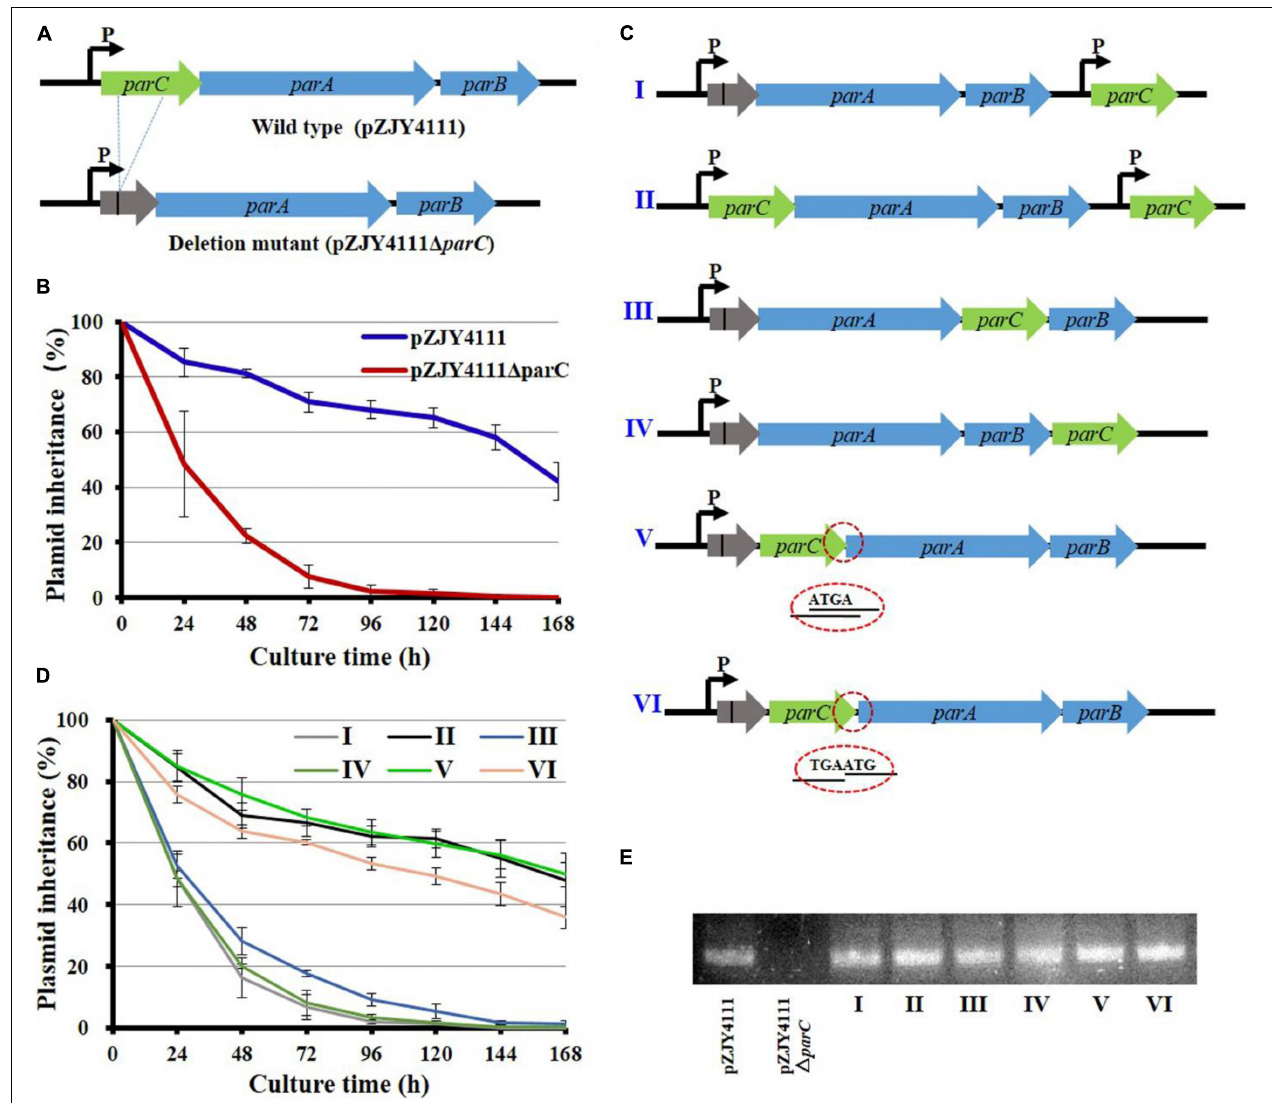
FIGURE 1 | Mutation and organization of the parC gene in the shuttle plasmid pZJY4111 and its effects on the inheritance stability of plasmid. (A) In-frame deletion of parC of the parCAB operon in pZJY4111. The deletion removed 228 bases and retained 11 N-terminal bases and 25 C-terminal bases of parC (referred to Supplementary Figure 3 ), producing plasmid pZJY4111 (cid:49) parC , which was further electro-transformed into M. xanthus DZ1 to assay the plasmid retention ability. Arrows indicate the direction of transcription. (B) Inheritance stability of pZJY4111 and pZJY4111 (cid:49) parC in M. xanthus DZ1. (C) Schematic representation for different locations of the compensatory parC gene in pZJY4111 (cid:49) parC or pZJY4111. These plasmids were separately transformed into M. xanthus DZ1 to assay their inheritance stabilities in M. xanthus DZ1 (D) . Error bars in (B,D) indicate the standard deviation (SD) of at least five independent experiments. The DZ1 strains with different plasmids were cultivated in CTT medium without antibiotics for 168 h, and the plasmid maintenance was examined every 24 h. (E) Transcriptional confirmation of the expression of parC in M. xanthus DZ1 containing different plasmids using quantitative